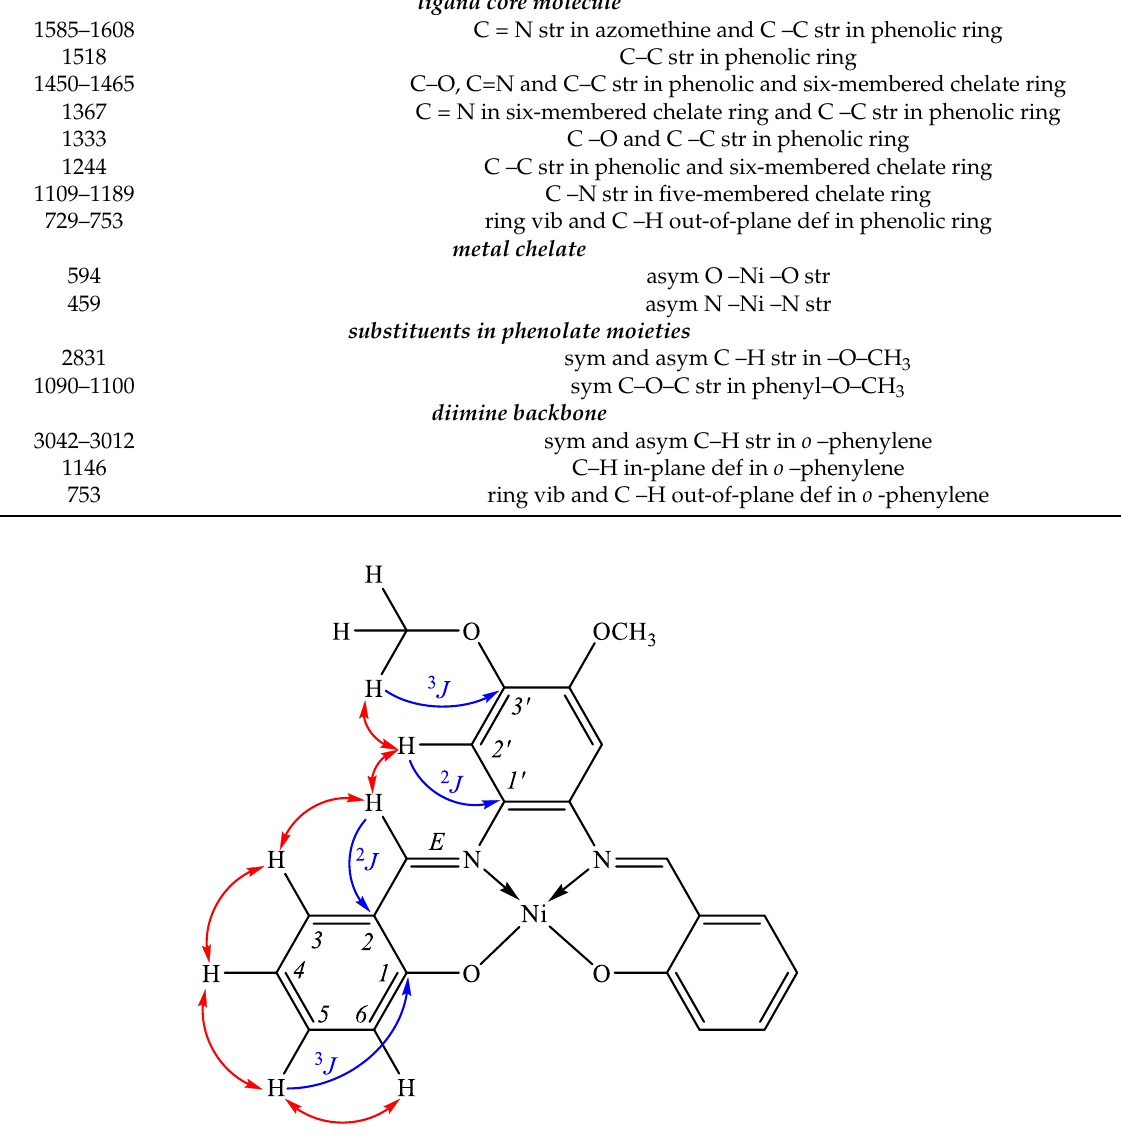
Figure 3. Key correlations in 1 H- 13 C HMBC (blue arrows) and 1 H- 1 H NOESY (double-edged red ar- rows) spectra. Table 2. IR band assignment according to [20].